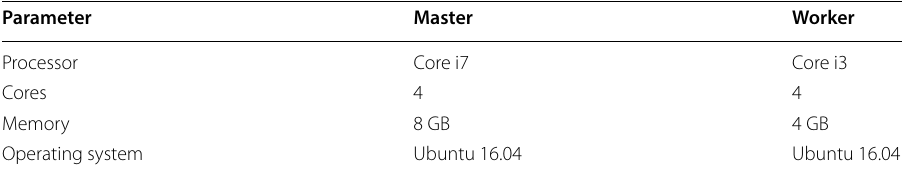
Table 3 Cluster nodes